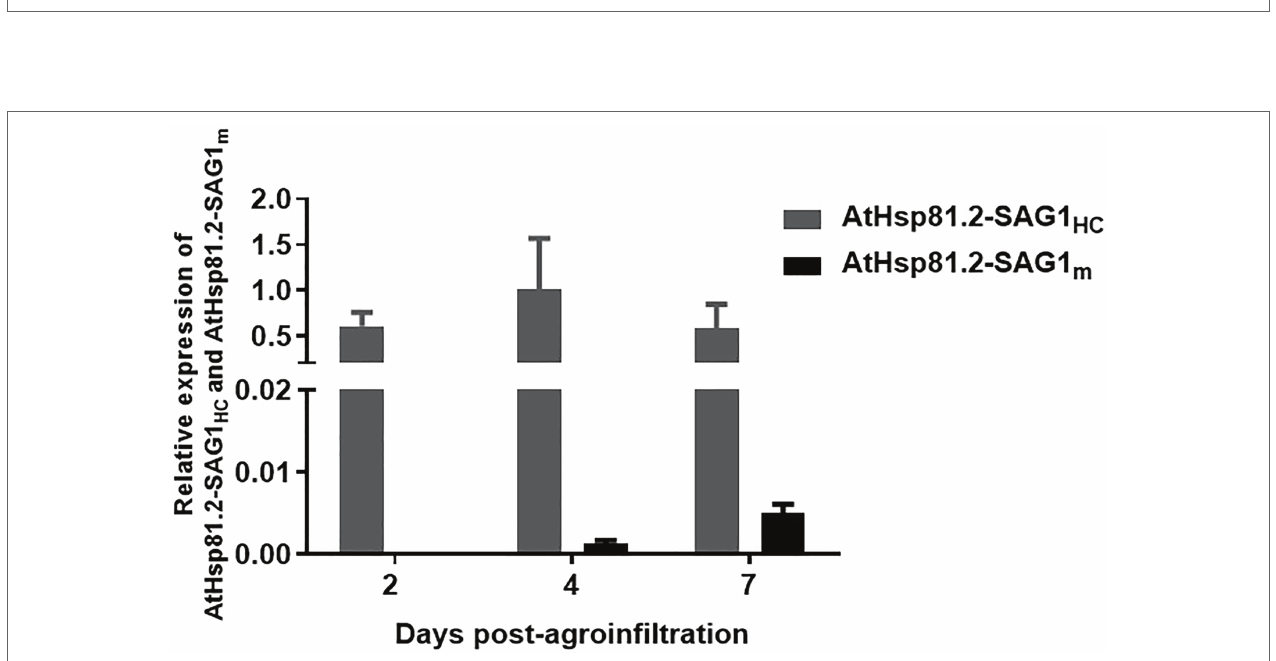
FIGURE 4 | Quantitative real-time polymerase chain reaction (RT-qPCR) analysis of AtHsp81.2–SAG1 HC and AtHsp81.2–SAG1 m genes in agroinfiltrated leaves. For each time point after agroinfiltration (2, 4, and 7 days), relative levels of expression for both genes are shown relative to the Nicotiana tabacum elongation factor-alpha ( NtEF α ) gene and are presented as means ± standard error of the mean (SEM) of three independent agroinfiltration